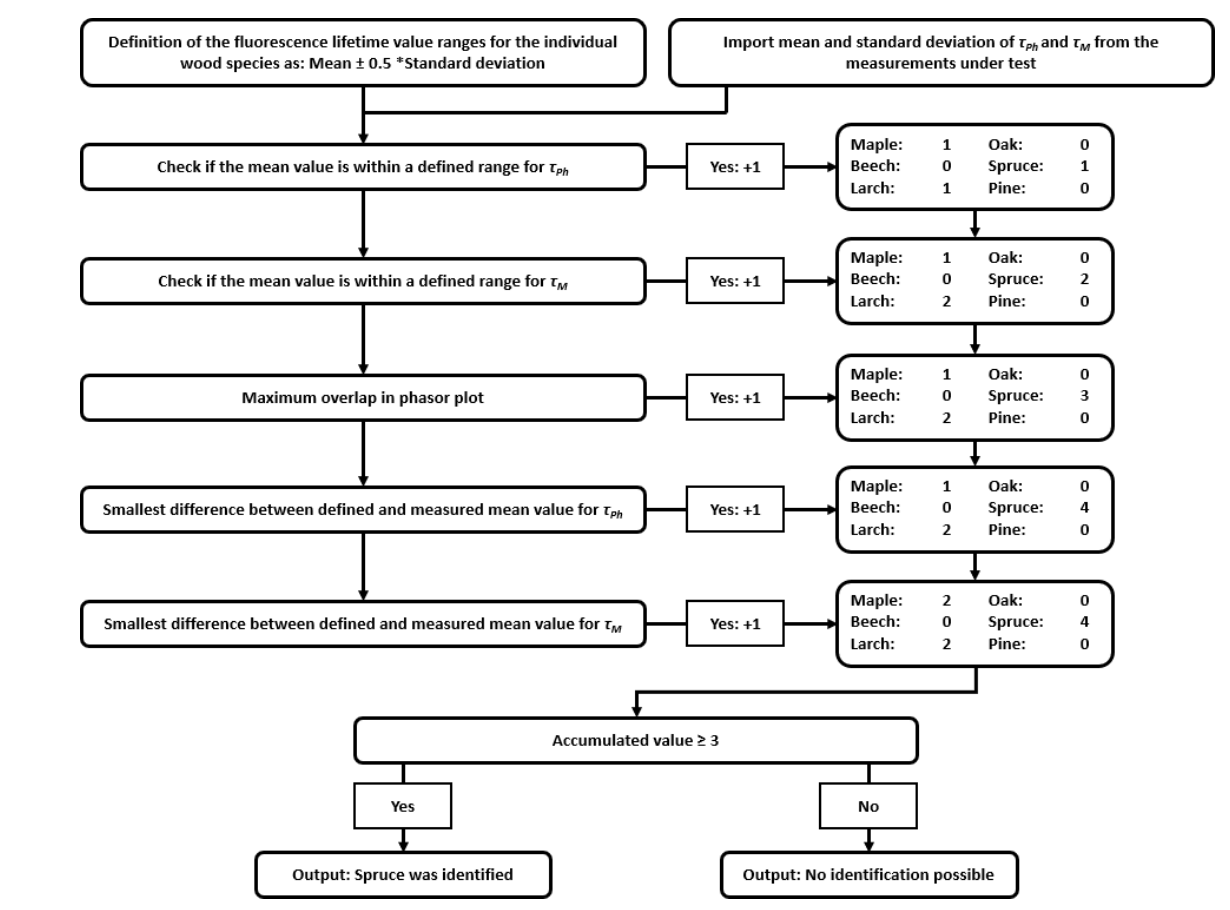
Figure 5. Flow chart of the evaluation decision tree to identify the wood